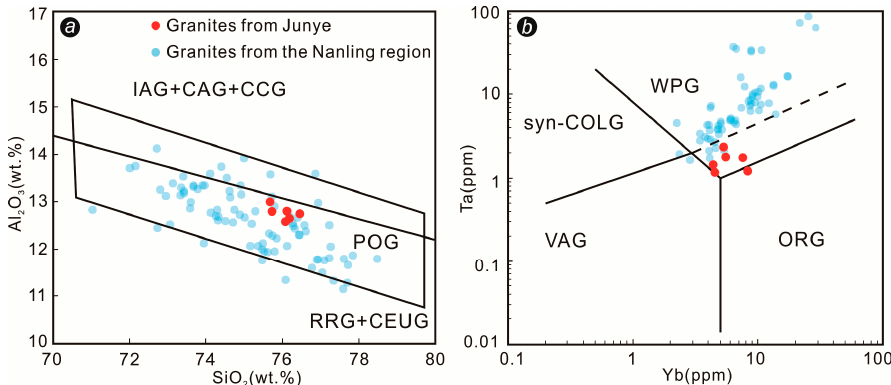
Figure 10. Discrimination diagrams relevant to the tectonic setting: ( a ) plots of Al 2 O 3 vs. SiO 2 , fields after Maniar et al. [60]; ( b ) plots of Ta vs. Yb, fields after Pearce et al. [104]. Abbreviations: WPG = within plate granites; syn-COLG = syn-collision granites; VAG = volcanic arc granites; ORG = ocean ridge granites; IAG = island arc granites; CAG = continental arc granites; CCG = continental collision granites; POG = post-orogenic granites; RRG = rift related granites; CEUG = continental epeirogenic uplift